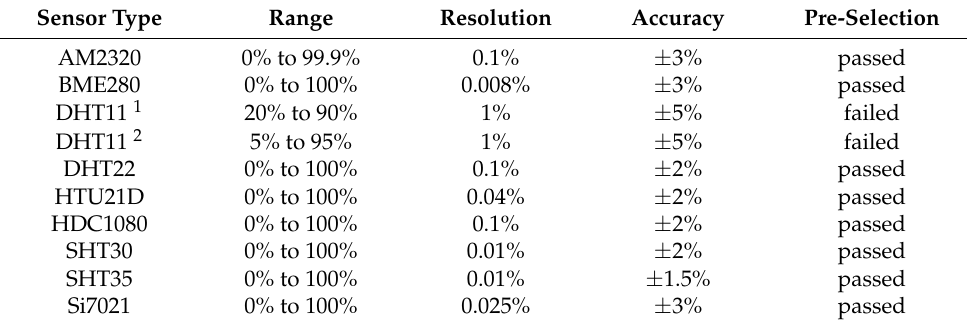
Table 6. Pre-selection of relative humidity